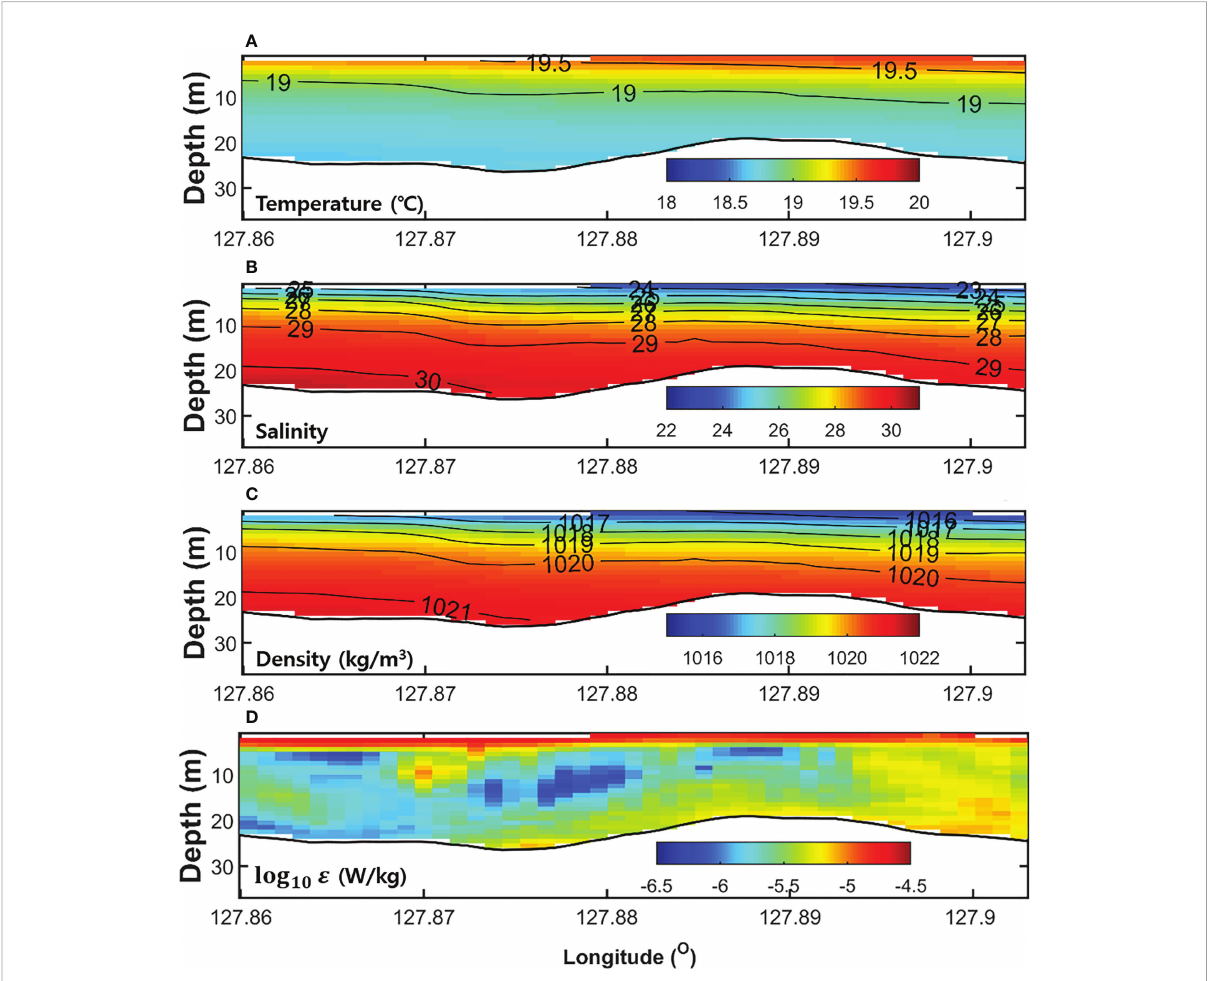
FIGURE 8 Vertical pro fi les of (A) temperature, (B) salinity, (C) density, and (D) dissipation rates in the control experiment along Noryang Channel (the cyan line in Figure 1) averaged from 26 June to 24 July.